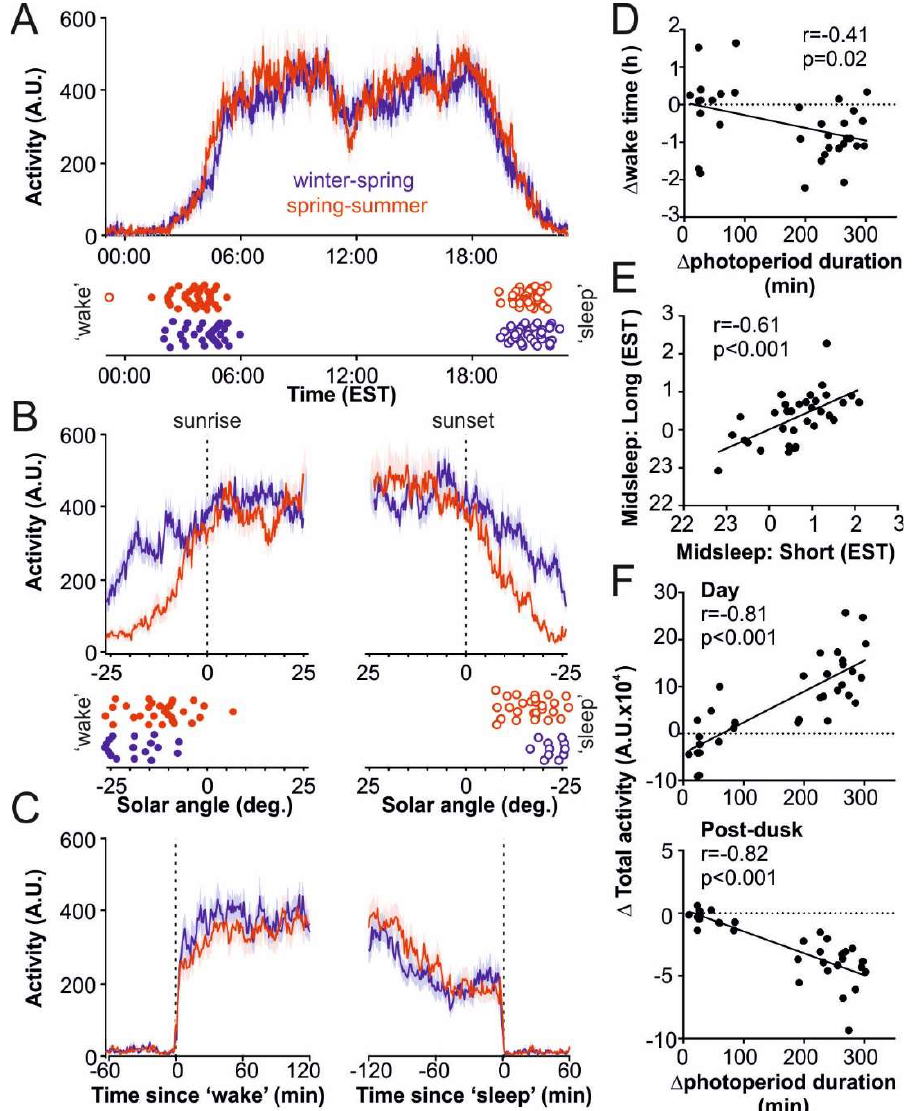
Figure 1. Photoperiod-related differences in activity timing in the Old Order Amish (OOA). ( A ) Mean ± SEM daily activity patterns for OOA subjects during winter / spring or spring / summer; lower panel indicates wake and sleep onset times for each subject ( n = 33). ( B ) Mean ± SEM activity patterns (upper panels) and wake / sleep onset times (lower panels) for subjects above as a function of sun position around dawn or dusk. ( C ) Mean ± SEM activity patterns for subjects above relative to actimetry-defined wake and sleep onset timing. ( D ) Relationship between seasonal change in wake onset time and photoperiod duration for these 33 OOA subjects. ( E ) Relationship between midsleep timing in these subjects under short and long photoperiods. ( F ) Relationship between seasonal change in total activity during the day (top) or post-dusk (bottom) and photoperiod duration.